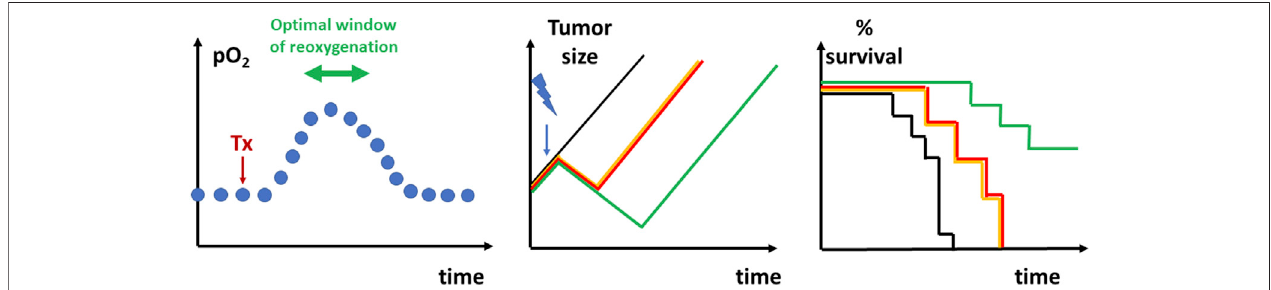
FIGURE6| Graphicaldepictionoftheidenti fi cationofreoxygenationtimingtoradiosensitizetumors. Left: Longitudinalmeasurementsofoxygenation(forexample, using EPR oximetry) allows to de fi ne the window of reoxygenation after a pharmacological treatment (Tx). Depending of the treatment used and designed to alleviate tumor hypoxia, the window of reoxygenation may occur minutes, hours or days after initiation of a treatment. Middle: tumor regrowth delay experiment. Non-treated tumors (black) will progress regularly over time. Irradiated tumors (yellow) using suboptimal dose will typically present a transient decrease in tumor size due to the cytotoxic effect in a fraction of tumor cells before regrowing. The combination of a treatment together with irradiation administered outside the window of reoxygenation (red) will not lead to an increase in regrowth delay. The combination of the treatment with irradiation in the optimal timing of reoxygenation (green) is increasing the regrowth delay as more cells are killed by the irradiation. Right : Kaplan Meier curve representing the surviving fraction as a function of time depending on the treatment (colors represent the same groups than in the middle panel).